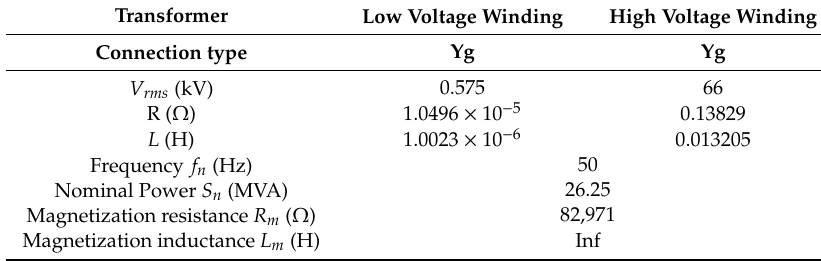
Table A2. Parameters of the three-phase 0.575 / 66 kV transformer of Wind farm B.